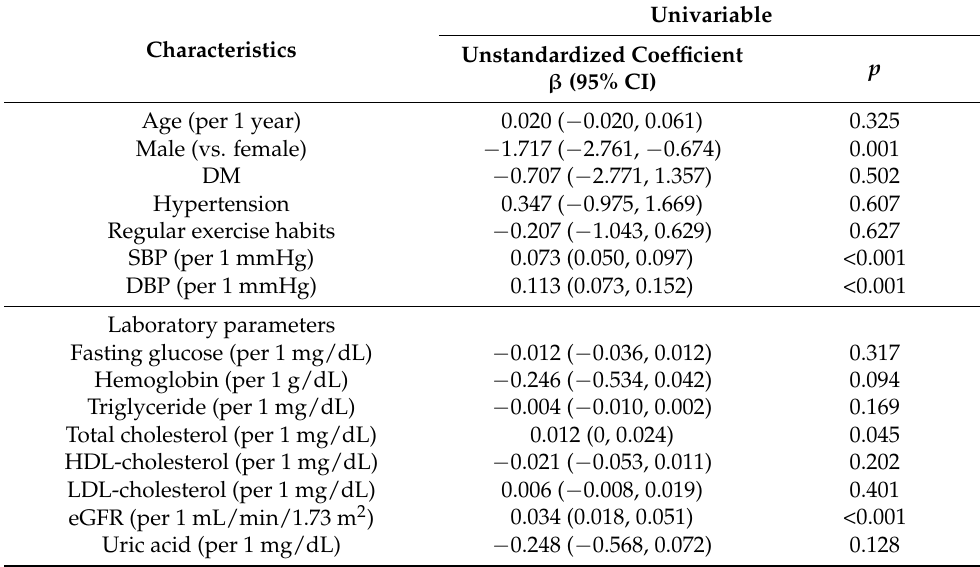
Table 4. Determinants for ∆ FEV1/FVC using univariable linear regression analysis.